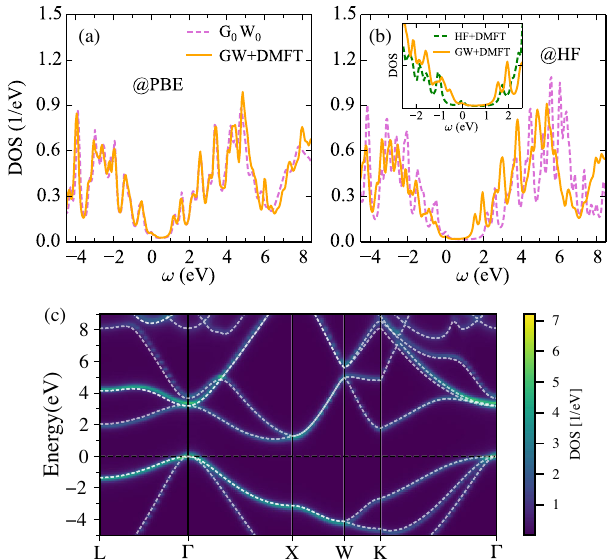
FIG. 2. Full cell GW þ DMFT results for silicon. (a),(b) Local spectral function from GW þ DMFT [Perdew-Burke-Ernzerhof (PBE) reference] and GW þ DMFT (HF reference). Inset in (b): GW þ DMFT compared to HF þ DMFT ( 4 × 4 × 4 k -mesh and GTH-DZVP basis) DOS taken from Ref. [39]. (c) Band structure starting from PBE orbitals. The heat map represents the GW þ DMFT@PBE result, and the dashed line gives the G 0 W 0 bands. A broadening factor of 0.1 eV is